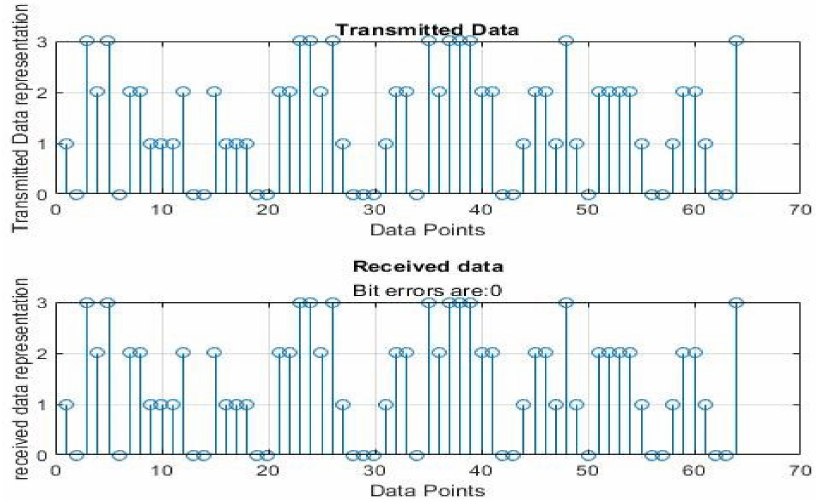
Figure 4. GAWDO QPSK output for 64 data points in a noiseless channel.